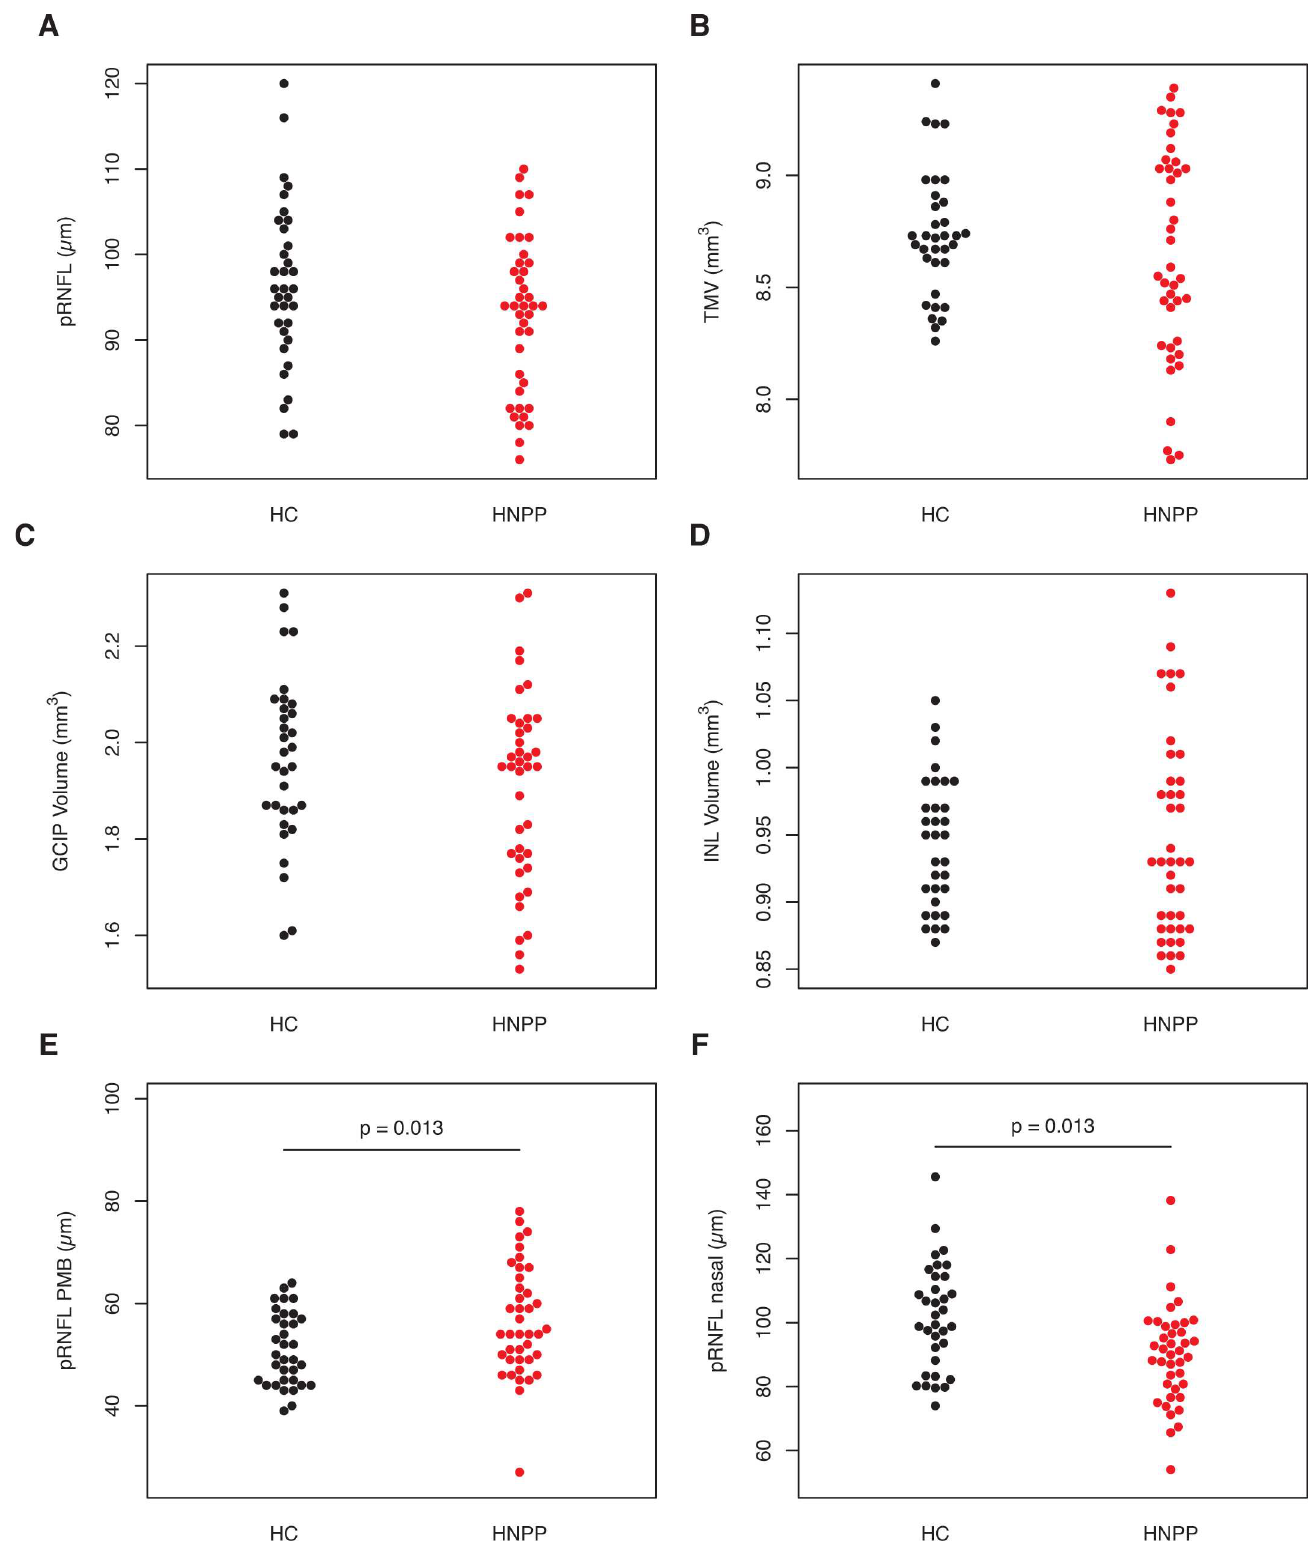
Fig 3. Optical Coherence Tomography. Differences in retinal optical coherence tomographymeasurements between HNPP patients (in red) and healthy controls (HC, in grey). A) Peripapillary retinal nerve fiber layer thickness (pRNFL), B) pRNFL in the papulomacular bundle(PMB), C) pRNFL in the nasal hemisphere, D) total macular volume (TMV), E) ganglioncell and inner plexiform layer (GCIP), F) inner nuclear layer (INL). P values are derived from generalizedestimating equation